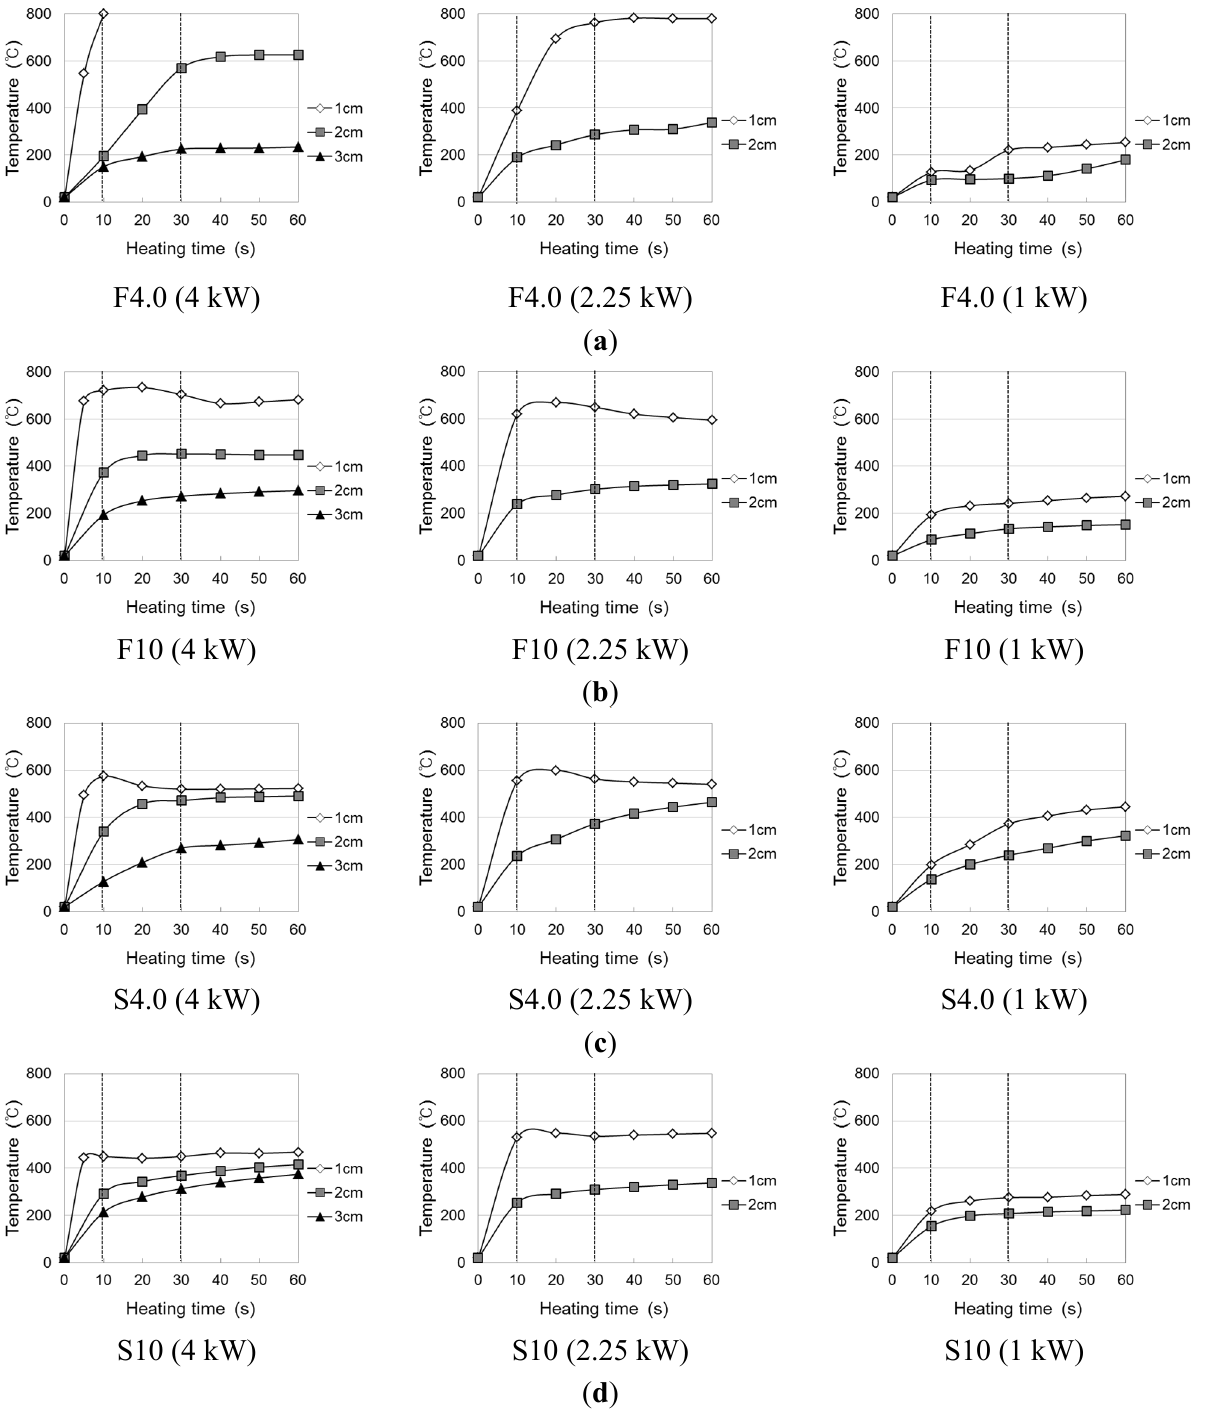
Figure 6. Temperature elevation of induction heating of conductive resistor (Metal mesh). ( a ) Wire fabric of 4 mesh; ( b ) wire fabric of 10 mesh; ( c ) stainless fabric of 4 mesh; ( d ) stainless fabric of 10